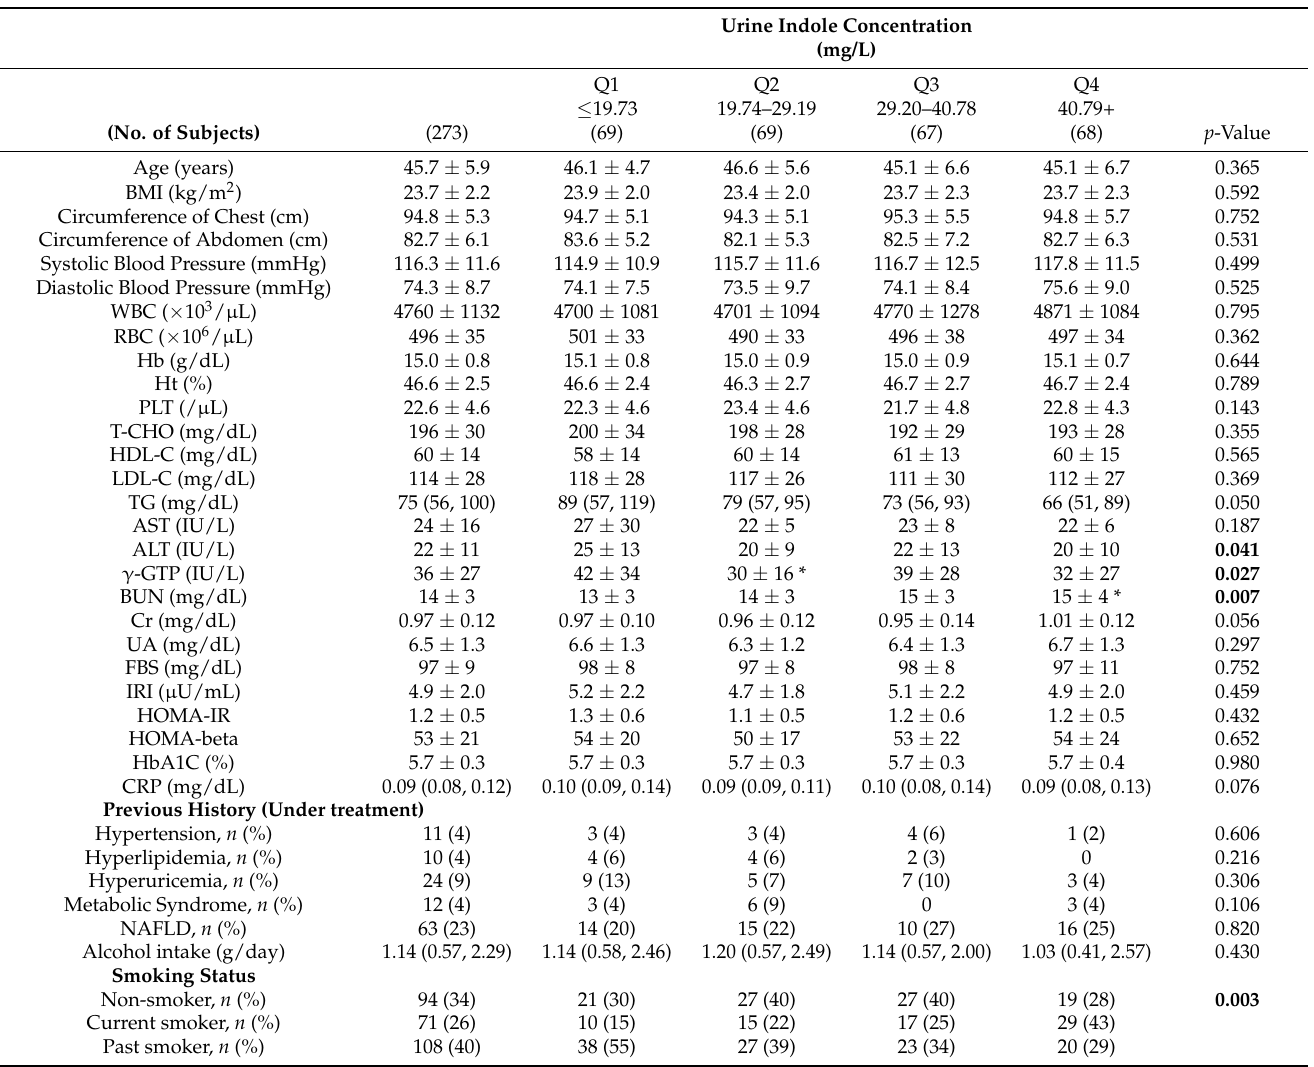
Table 1. Background characteristics of the